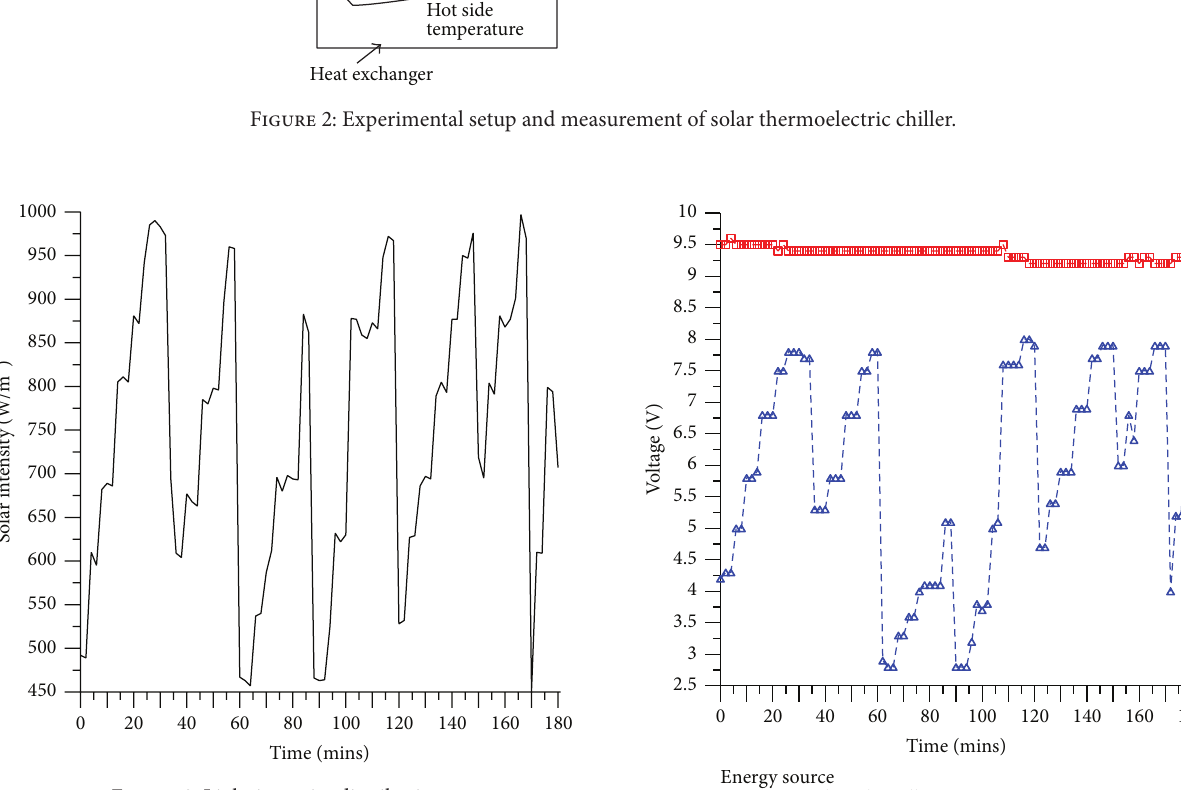
Figure 3: Light intensity distribution.